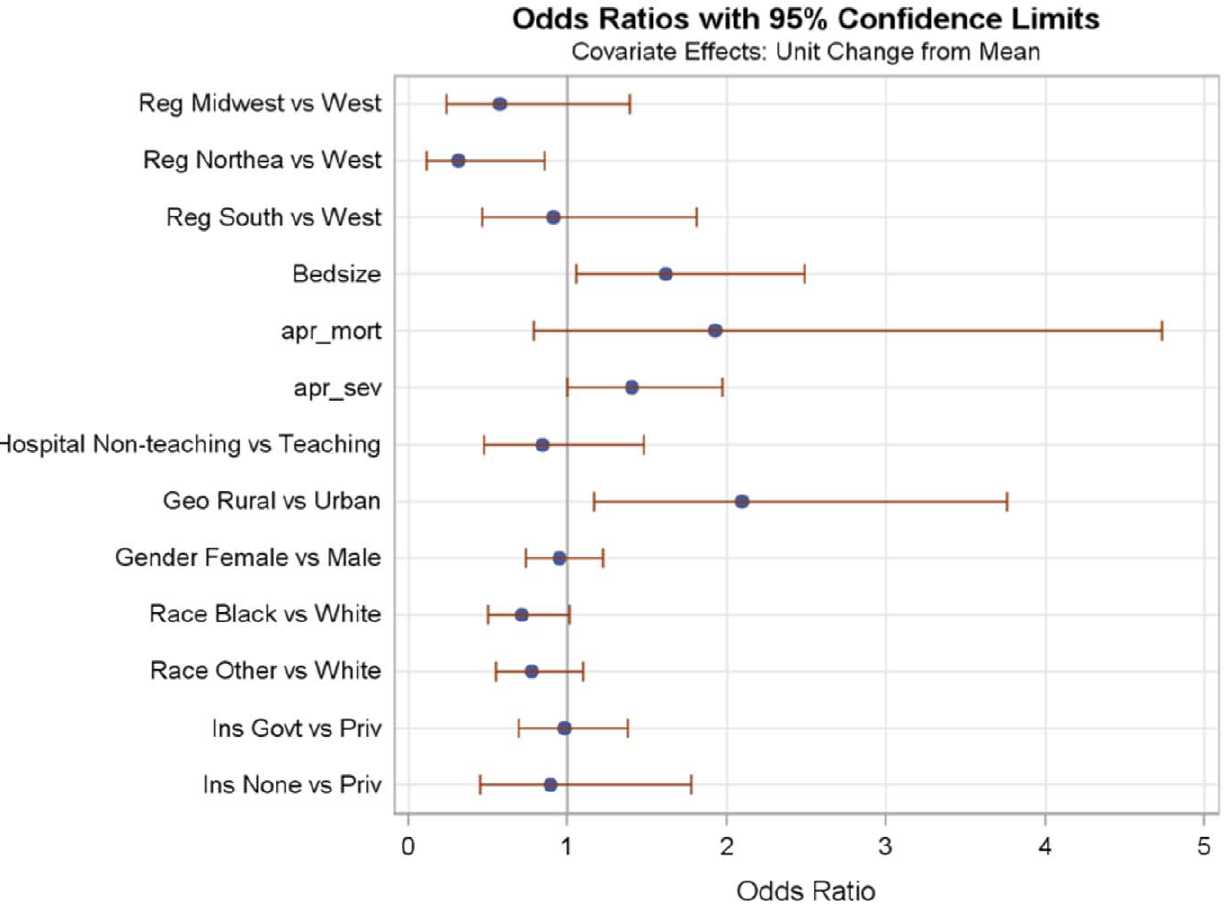
Figure 3. Odds Ratios for models in patients under 1 year of age ICD-9-CM group ‘‘Infections of skin and subcutaneous tissue’’.